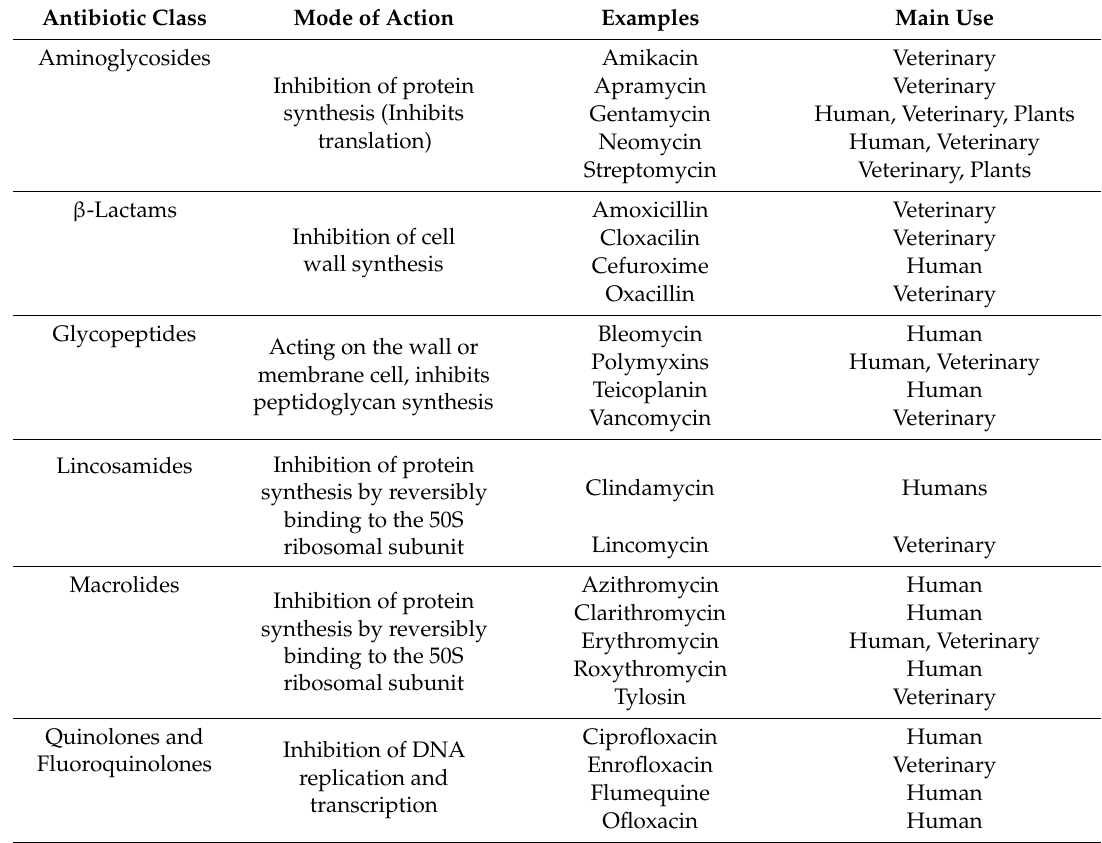
Table 1. Main classes of antibiotics, with their mode of action, examples of compounds, and their main use